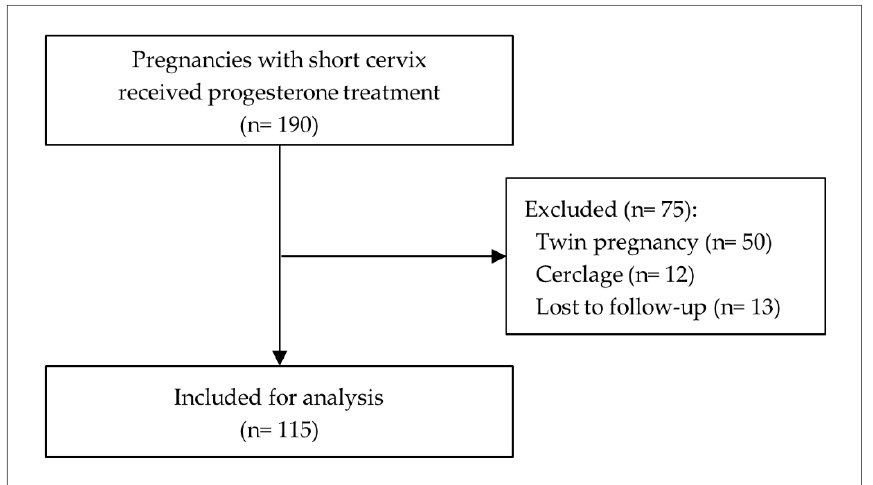
Figure 2. Study population.